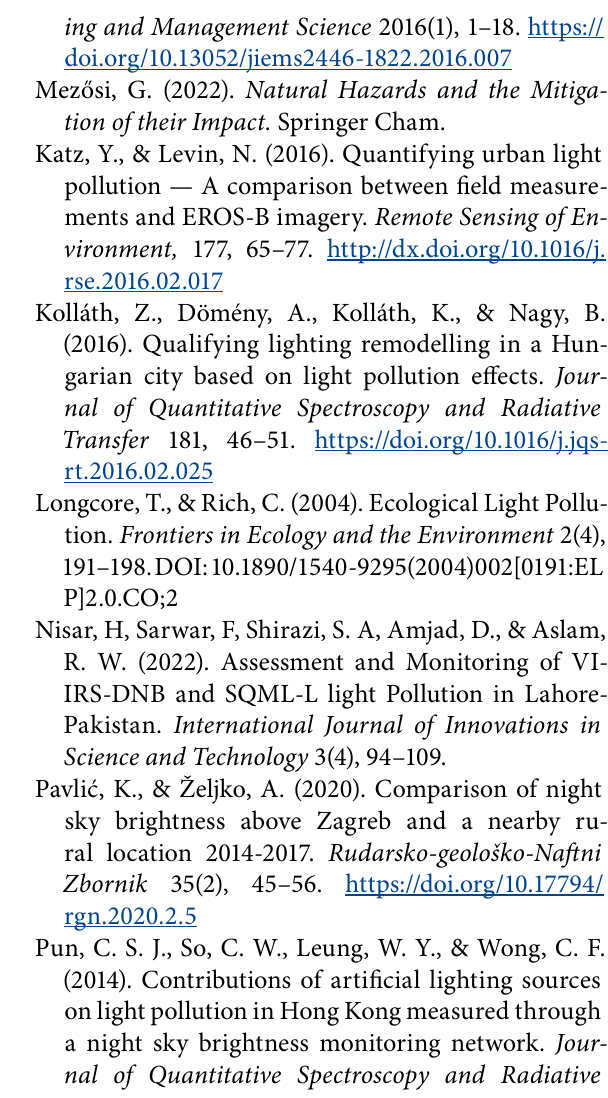
Figure 6.B. Neighbourhoods with the lowest (blue) and highest level of astronomical light pollution based on THI_R, TIN_R, and VIIRS_R in 2019